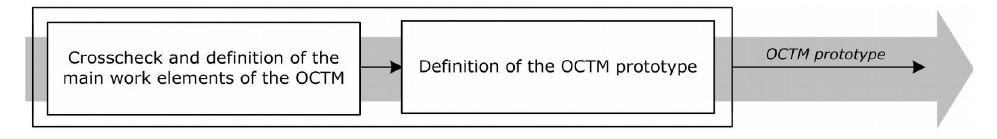
Figure 7. Workflow of OCTM prototype definition